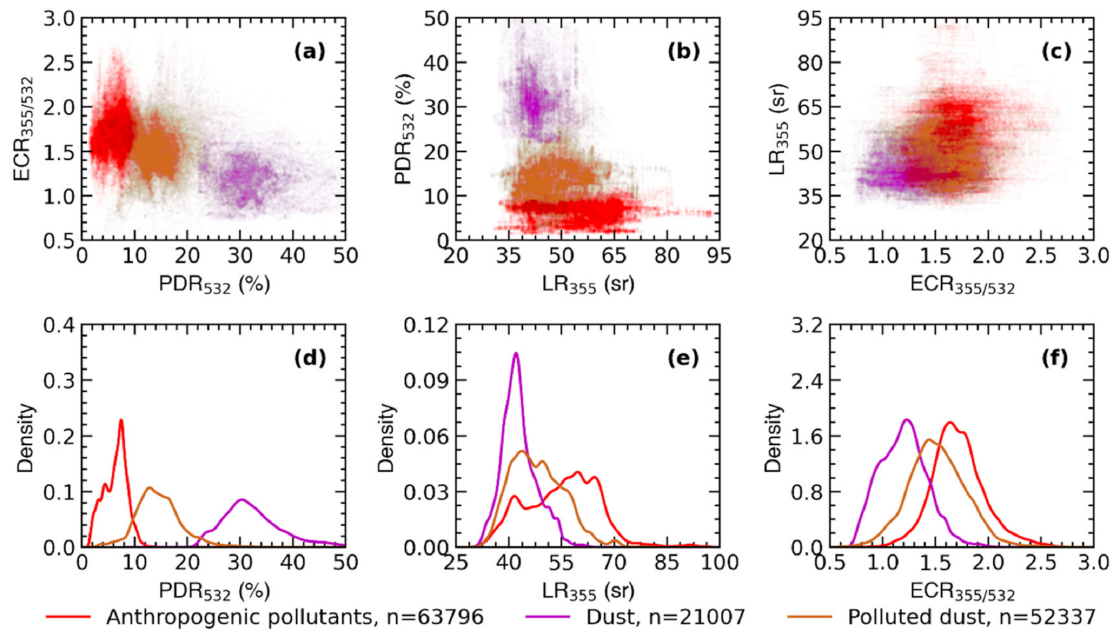
Figure 5. Characteristics of key aerosol types in Beijing–Tianjin–Hebei (BTH) region measured by MRL. Two-dimensional projections of ( a ) PDR 532 versus ECR 355/532 , ( b ) LR 355 versus PDR 532 , and ( c ) ECR 355/532 versus LR 355 are color-coded by inferred aerosol types, the saturation of each hue represents the relative population density. The frequency distribution of ( d ) PDR 532 , ( e ) LR 355 , and ( f ) ECR 355/532 of key aerosol types in BTH region, as well as the the number of points (n) of each aerosol type measured by